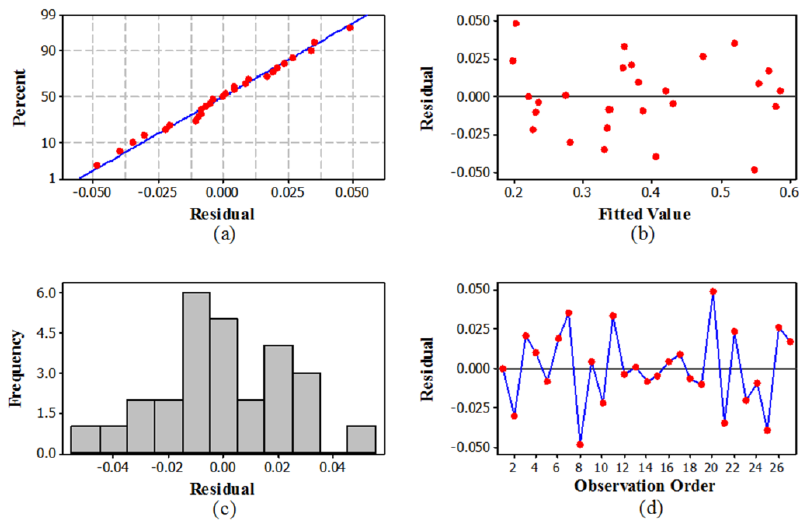
Figure 7. Plot of residuals for surface roughness. ( a ) Normal probability plot of the residuals, ( b ) residuals versus the fitted values, ( c ) histogram of the residuals, ( d ) residuals versus the observation order.